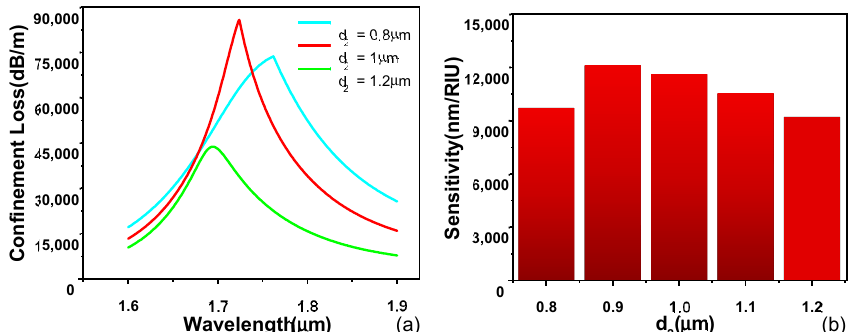
Figure 5. The loss spectra ( a ) and sensitivity ( b ) for various small air holes’ diameters d 2 . The other parameters are d = 1.6 μ m, t ITO = 60 nm, h = 6.4 μ m, n a = 1.38.